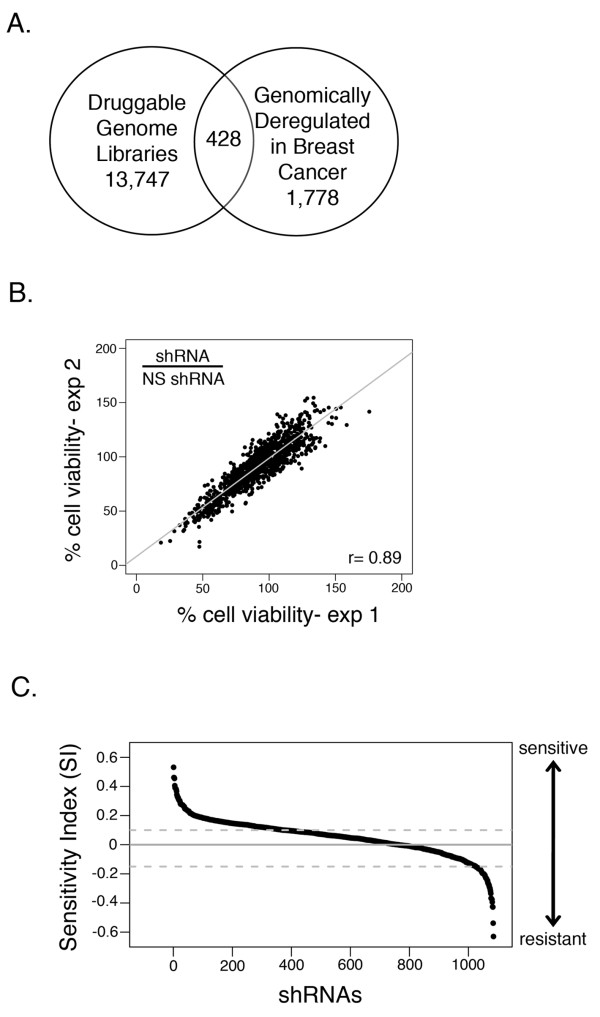
shRNA screen to identify paclitaxel sensitizers. A. The overlay of druggable genome libraries (Qiagen and Open Biosystems) and genes deregulated in breast cancer resulted in 428 candidate druggable genes. B. Reproducibility of shRNA screen by correlation of the effect of shRNAs on cell growth compared to non-silencing shRNA in vehicle-treated plates of two replicate experiments. Spearman correlation coefficient, r = 0.89. C. Each shRNA was scored for the level of paclitaxel sensitivity using the sensitivity index (SI) as described in Materials and Methods. The SI score ranges from -1 to 1. Positive significant SI scores indicate sensitization and negative significant SI scores indicate antagonism. The scatter plot of all shRNAs is shown in rank order. The dashed lines indicate the relative threshold of significant drug sensitivity.